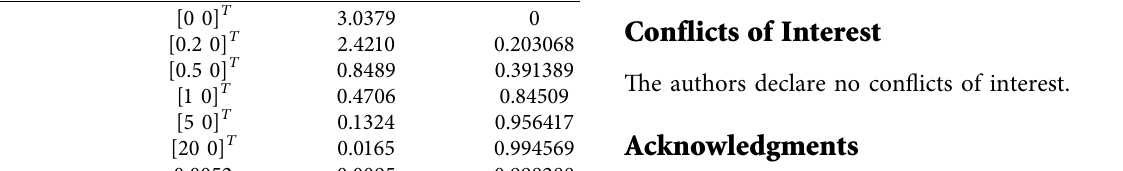
Table 2: DOS for different values of L Serial